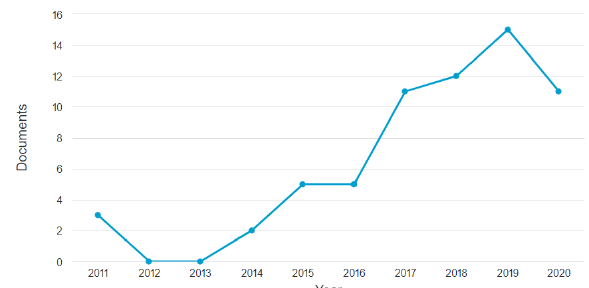
Figure 2 : Growth trend in research interest in wearable technologies within the construction site (Source: Scopus database; Search range: 2010-2020; Search terms: "wearable AND technology" AND "construction AND